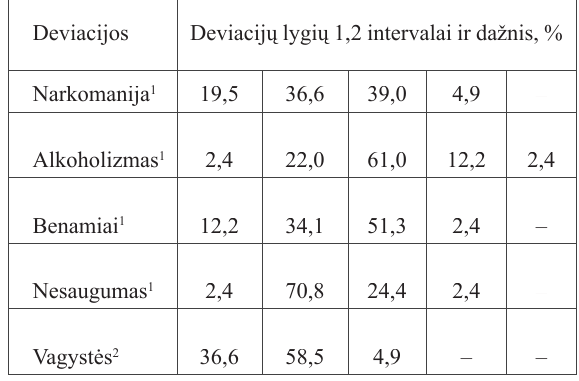
Table 1. Destribution of deviations level in Vilnius urban areas (2005)